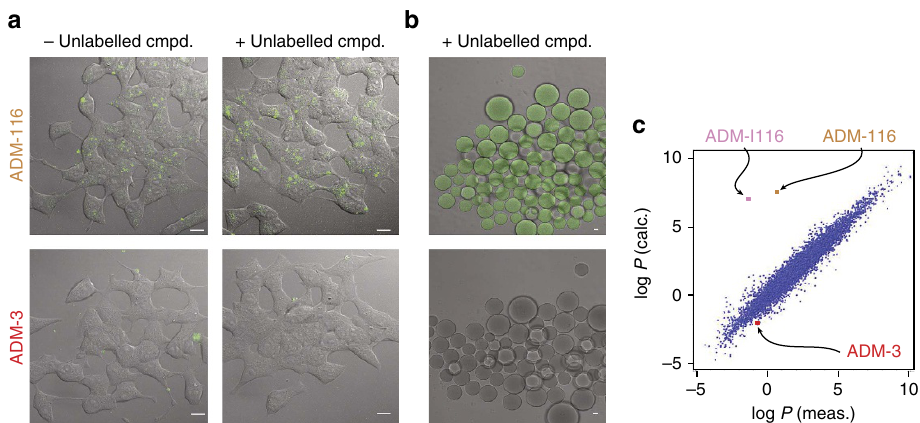
Figure 6 | Membrane translocation and partitioning. ( a ) Confocal fluorescence imaging of INS-1 cells incubated for 12h with 200nM ADM-116 F or 200nM ADM-3 F . Conditions shown are with and without addition of a further 15 m M of unlabelled small molecule. ( b ) GPMVs prepared from INS-1 cells incubated for 24h with 200nM ADM-116 F or ADM-3 F mixed with 10 m M of unlabelled compound. Scale bars, 5 m m ( a , b ). ( c ) Calculated versus measured octanol:water partition coefficients for three molecules used in this work (prepared using MolInspiration, http://www.molinspiration.com). United States approved pharmacopeia shown as blue dots. calc., calculated; cmpd., compound.